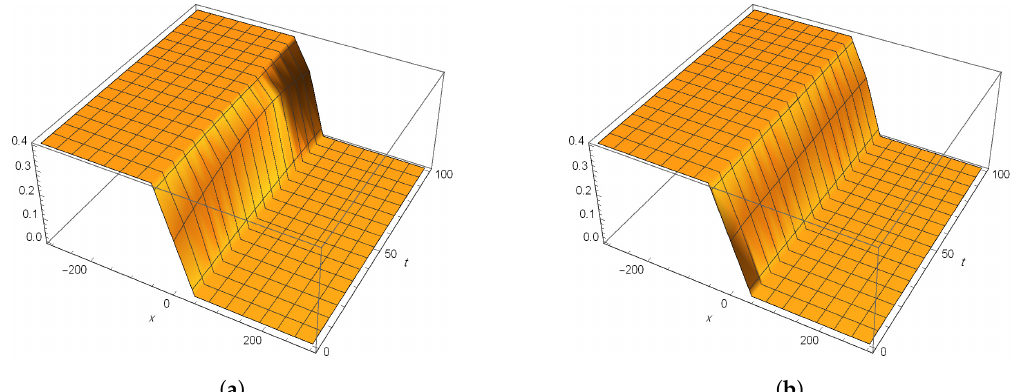
Figure 2. The third order approximation u 3 for ( a ) α = 0.9 and ( b ) α = 0.5, a = 1, b = 0.1, and c = 1.